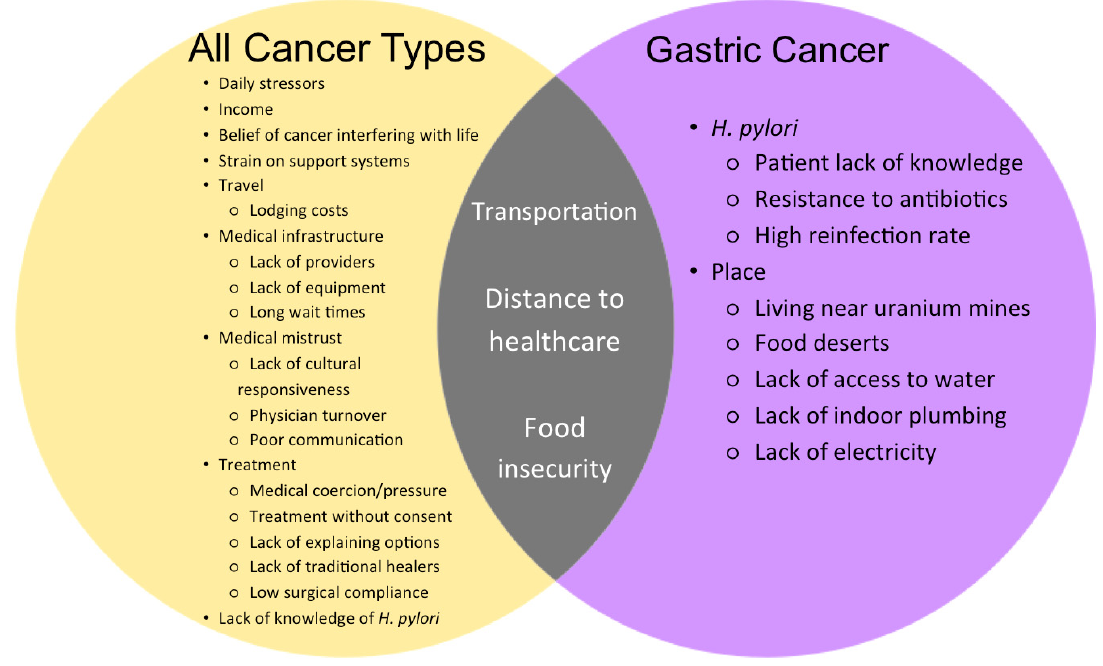
Figure 2. Issues Indigenous patients face in regards to access to cancer prevention and control for all types of cancer (yellow), gastric cancer alone (purple) and both (grey) [7,13,15–17,21,23,26–28,37,44–49].